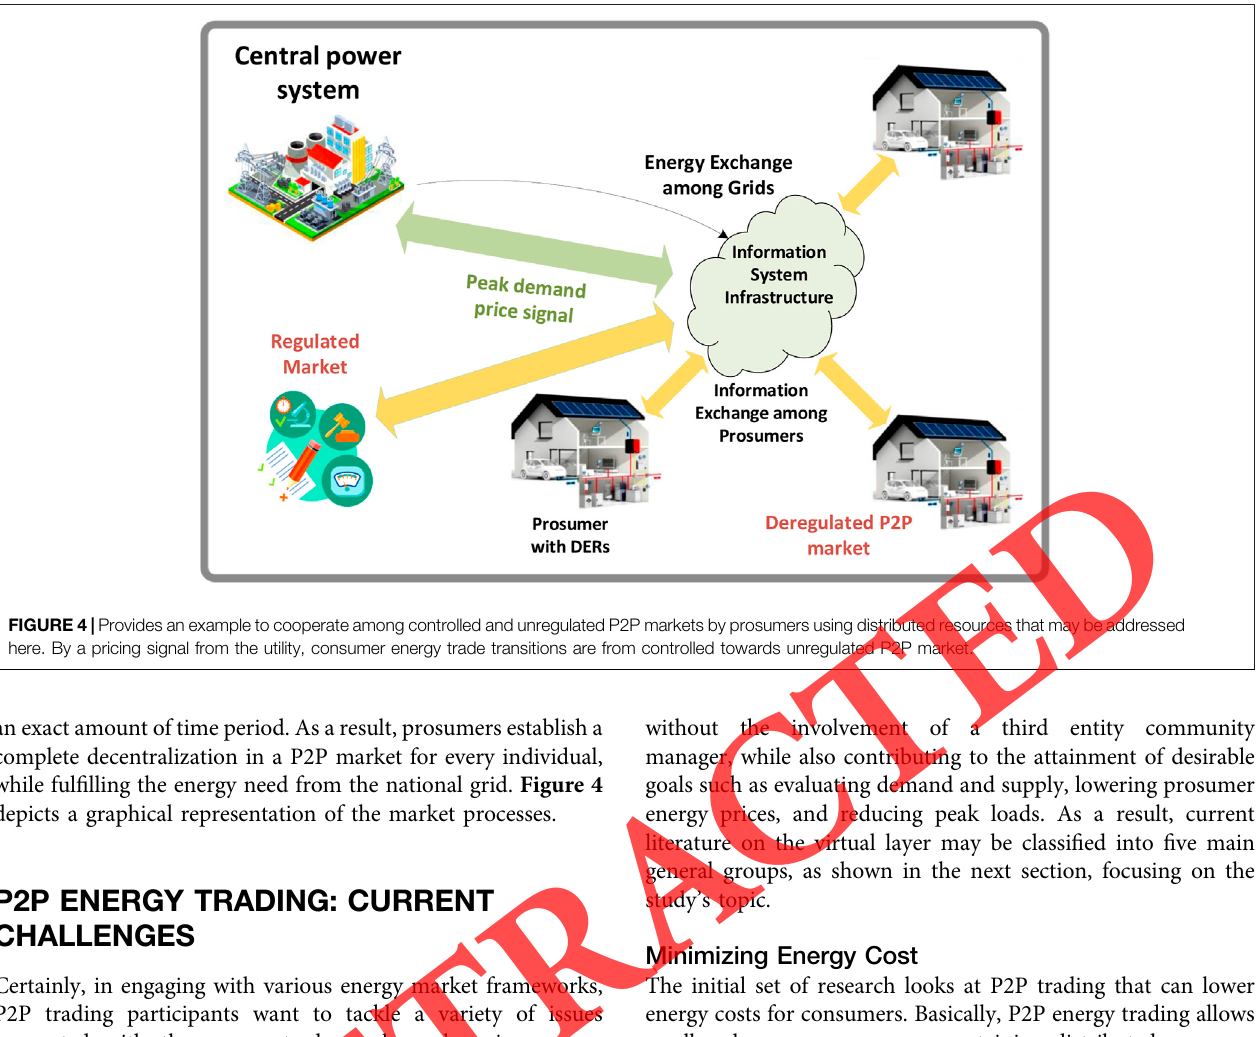
FIGURE 4 | Provides an example to cooperateamong controlled and unregulated P2P markets by prosumers using distributed resources that may be addressed here. By a pricing signal from the utility, consumer energy trade transitions are from controlled towards unregulated P2P market.